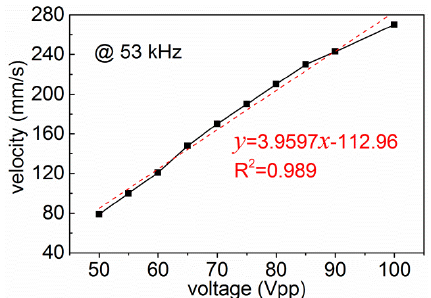
Figure 12. Velocity of the stage vs. applied voltage peak-peak value.